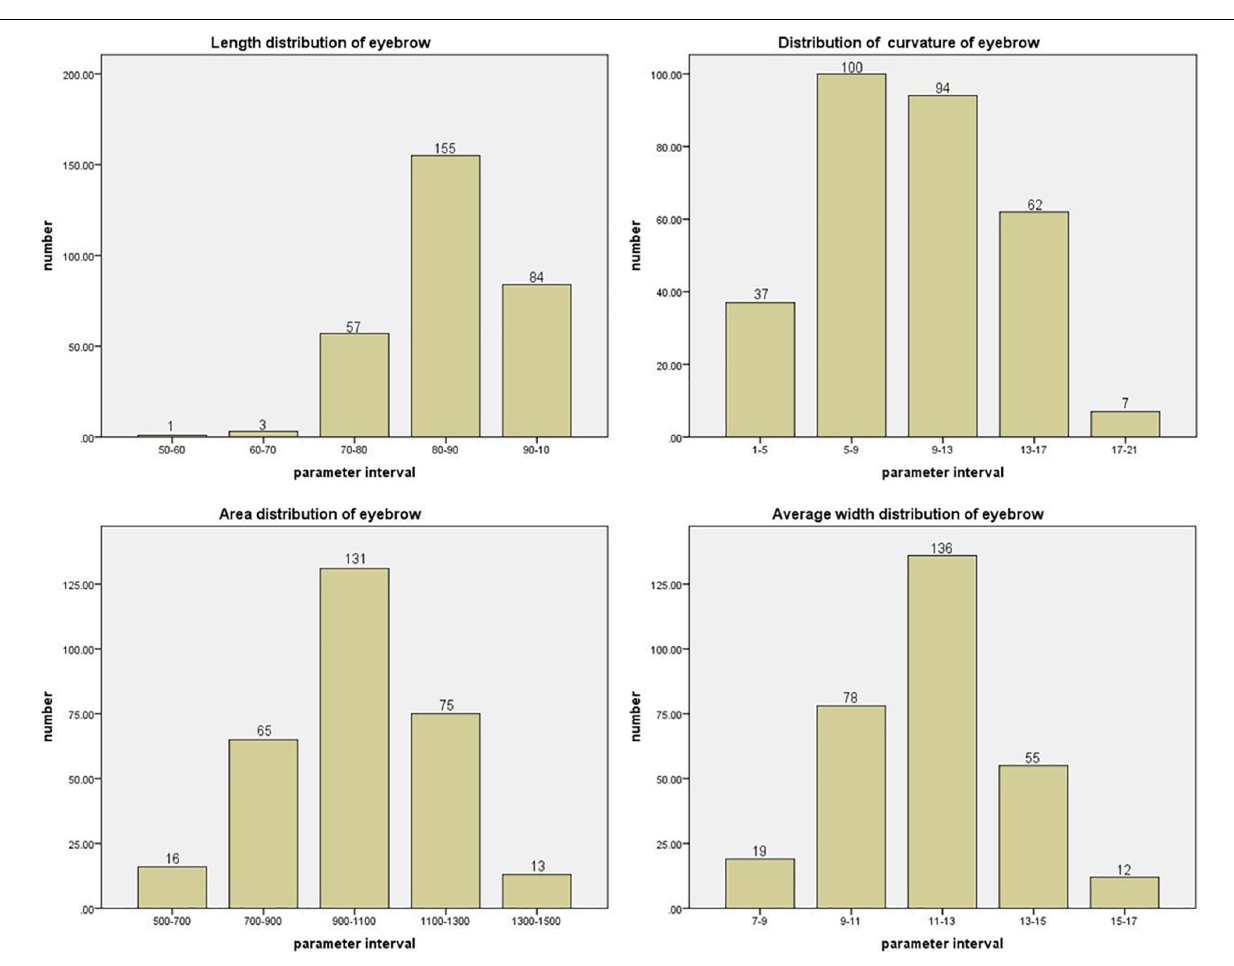
we design a custom hairline detector because the height of the face needs to be calculated, which adds a point to the hairline on the basis of the 68 feature points in Figure 2 . The transverse to longitudinal ratios of four typical facial shapes are shown in Figure 9